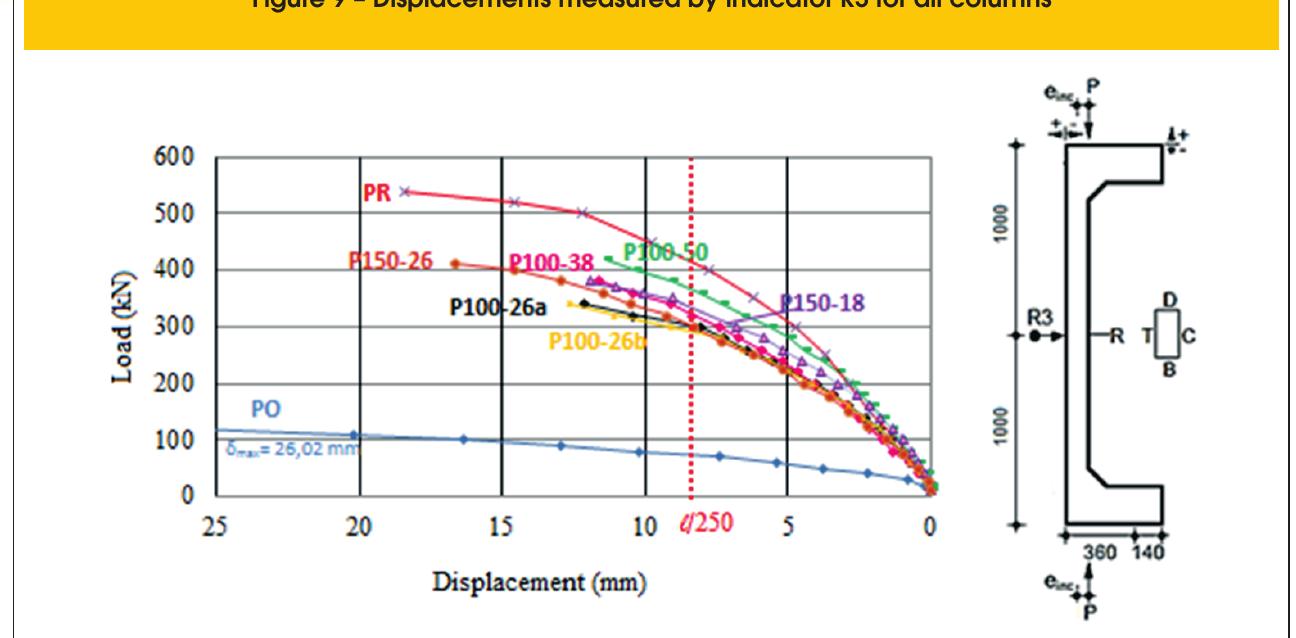
Figure 9 – Displacements measured by indicator R3 for all columns